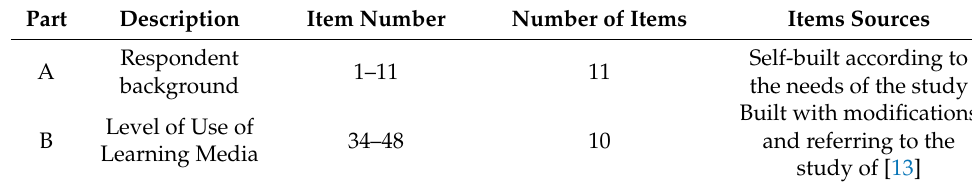
Table 2. Questionnaire Information.